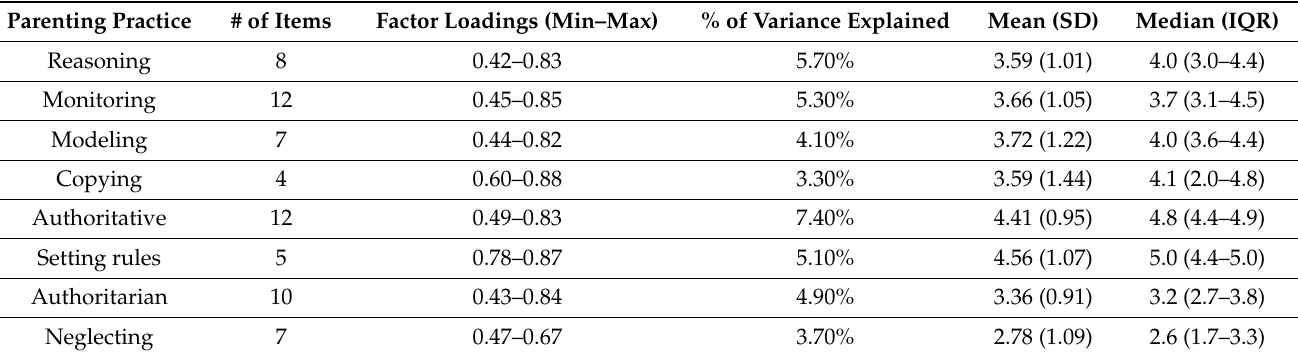
Table 3. Factor analysis for parenting